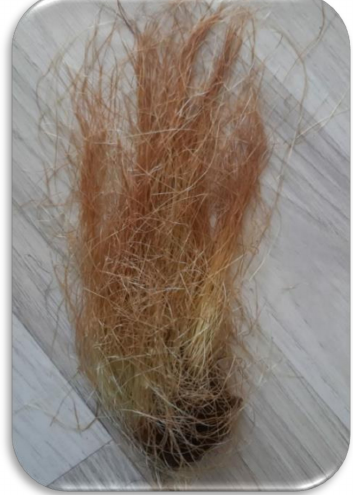
Figure 1. Cornsilk collected from maize ( Zea mays